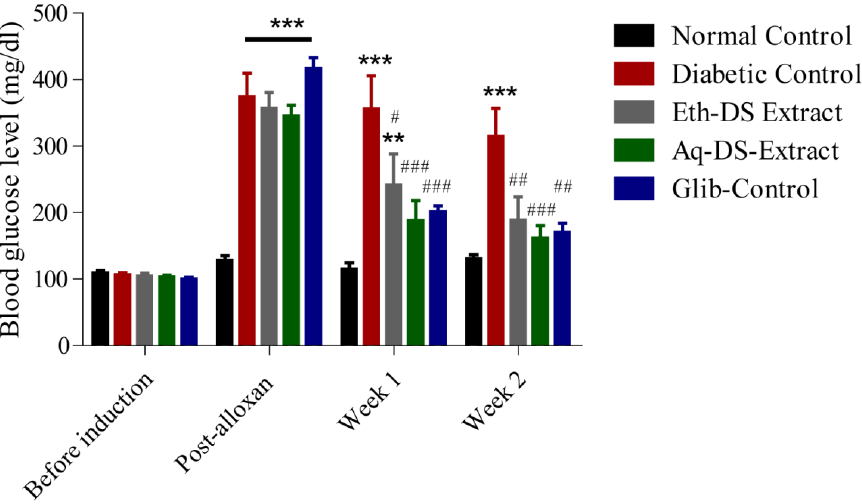
Figure 5. Effects of DS extracts (ethanol and aqueous) and glibenclamide on blood glucose levels of alloxan induced diabetic mice, expressed as mean ± SD (n = 6 per group), ** p < 0.01, *** p < 0.001 compared to normal control, # p < 0.05, ## p < 0.01, ### p < 0.001 compared to diabetic control. (Eth-DS: Ethanolic extract of DS, Aq-DS: Aqueous extract ofDS, Glib: glibenclamide treated